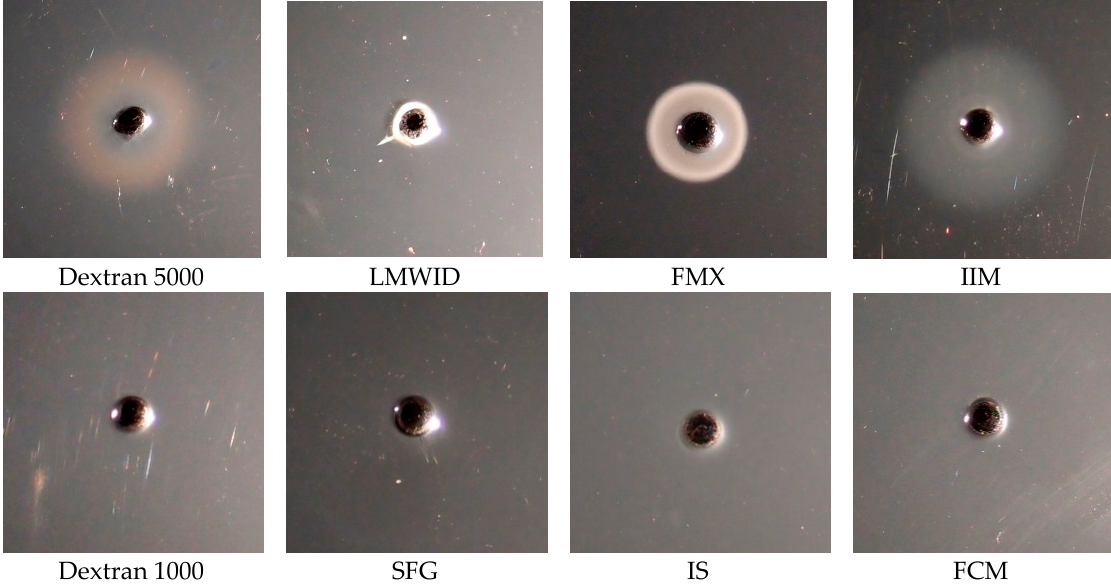
Figure 1. Reactivity of different IV iron preparations with 5E7H3 by reverse single radial immunodiffusion. Positive antigen/antibody reaction, indicated by circular turbidity around the well, is observed in the upper row for the positive control (dextran 5000) and the dextran/dextran-based preparations (LMWID, FMX, and IIM). In the lower row, the negative control (dextran 1000) as well as the non-dextran-based preparations (SFG, IS, and FCM) do not show any reaction. FCM, ferric carboxymaltose; FMX, ferumoxytol; IIM, iron isomaltoside 1000; IS, iron sucrose; LMWID, low molecular weight iron dextran; SFG, sodium ferric gluconate.